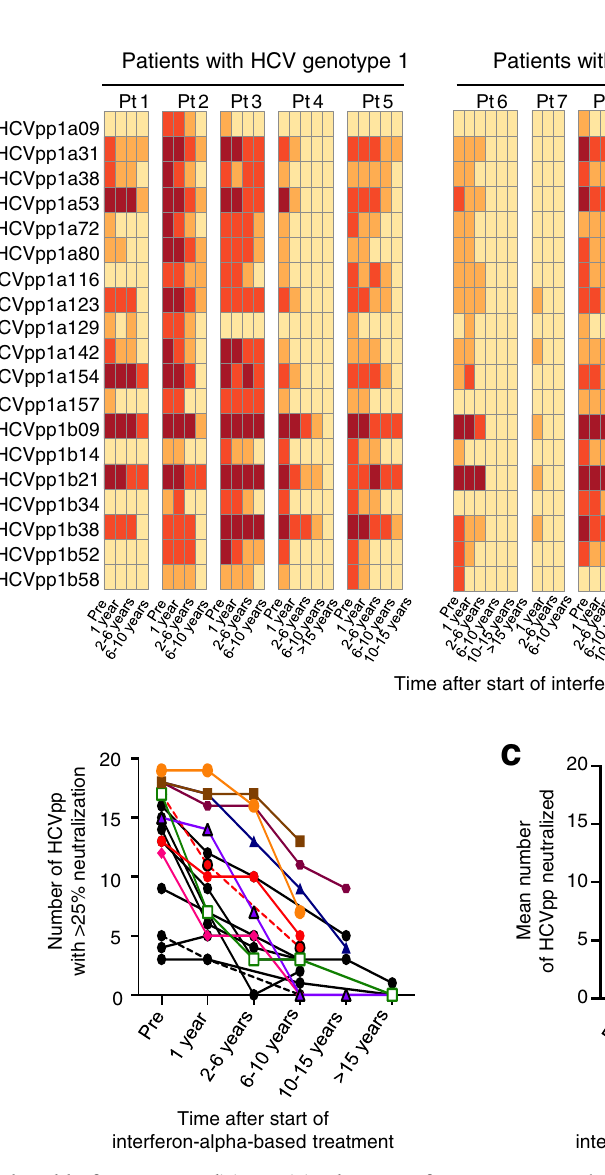
Fig. 3 | The breadth of serum neutralizing activity decreases after treatment- induced clearance of HCV. a The heat map represents the neutralizing activity of serially collected sera from patients ( n =17) at 4 – 6 time points prior to (pre) and after the start of interferon-alpha-based treatment of chronic HCV infection. Each serum was tested against a diverse panel of 19 HCVpp listed on the y-axis. The percentage of neutralization achieved by 1:100 dilution of serum, tested in